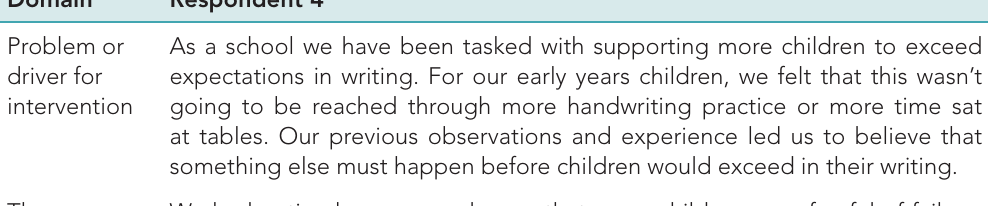
Table 2: An example of one respondent’s TofA